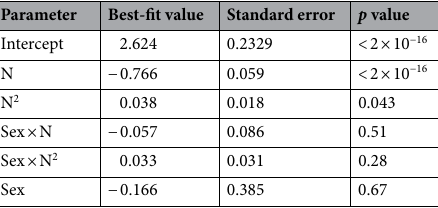
Table 2. Assessment of sex effects on dose reconstruction using mouse qRT-PCR data. Sex was included in the multiple regression model as a binary variable: male = 1, female = 0.